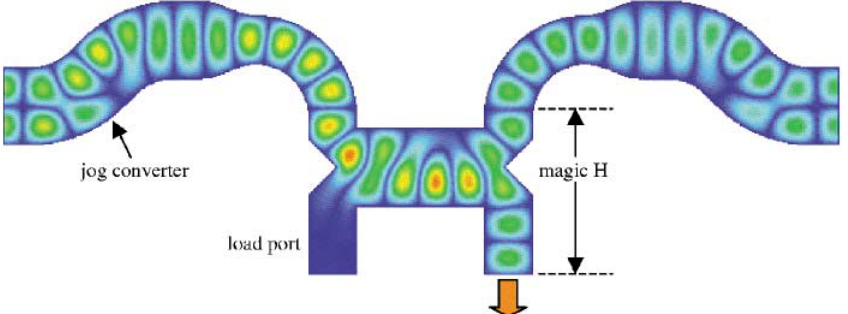
FIG. 11. (Color) A 3-dB directional coupler tap-off with simulated field plots. Power flow is from left to right.